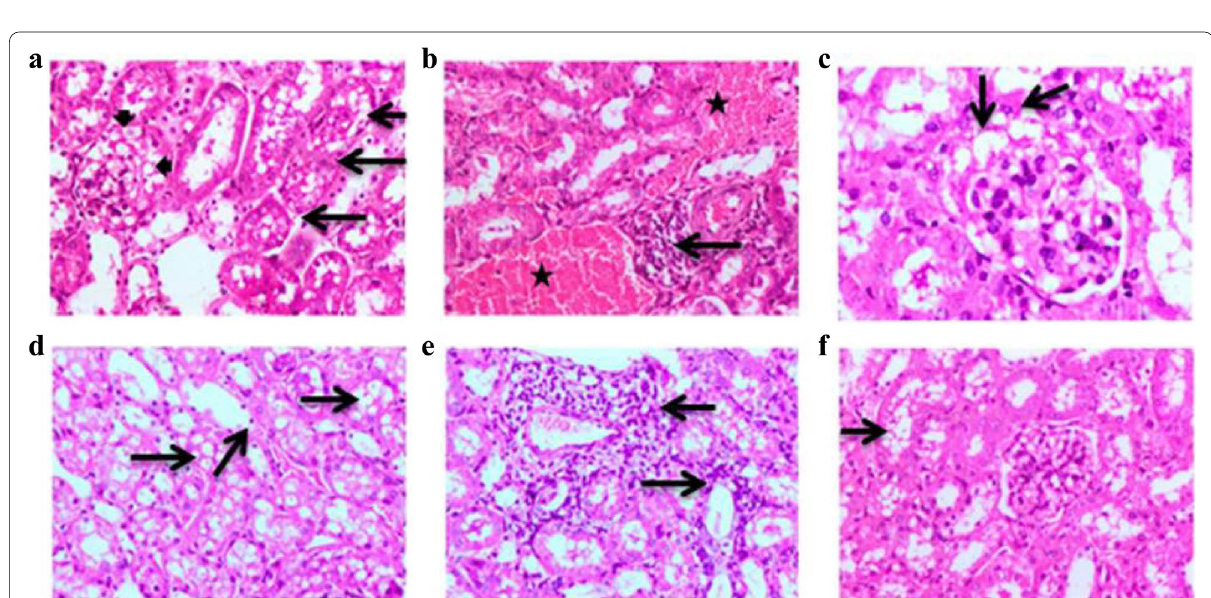
Fig. 2 a kidney of obesity pro2 group, showing vacuolar degeneration and necrosis of epithelial lining of renal tubules (black long arrows), vacuolation of glomerular tuft with presence of foam cells (black short arrows), b kidney of obesity pro2 group, showing extensive hemorrhage, dilatation & congestion of blood vessel (black stars) and focal aggregation of inflammatory cells (black long arrows), c kidney of obesity pro1 group, showing marked vacuolation of glomerular tuft (black long arrows), d kidney of obesity pro1 group, showing vacuolar degeneration associated with necrosis of epithelial cells (black long arrows), e kidney of obesity mix group, showing perivascular and interstitial aggregations of mononuclear inflammatory cells (black long arrows), and ( f ) kidney of obesity mix group, showing mild vacuolar degeneration of epithelial lining of some renal tubules (black long arrows) (H&E, ×